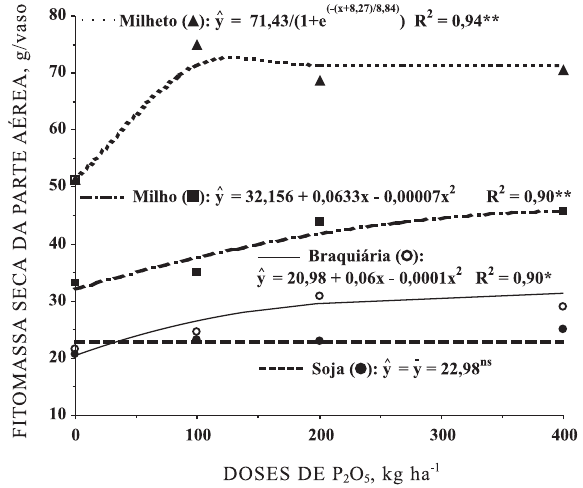
Figura 2. Fitomassa seca do milheto, braquiária, soja e milho aos 50 dias da emergência das plantas, em função da adubação com fosforita Alvorada. ns: não-significativo. * e ** significativos a 5 e 1 %,